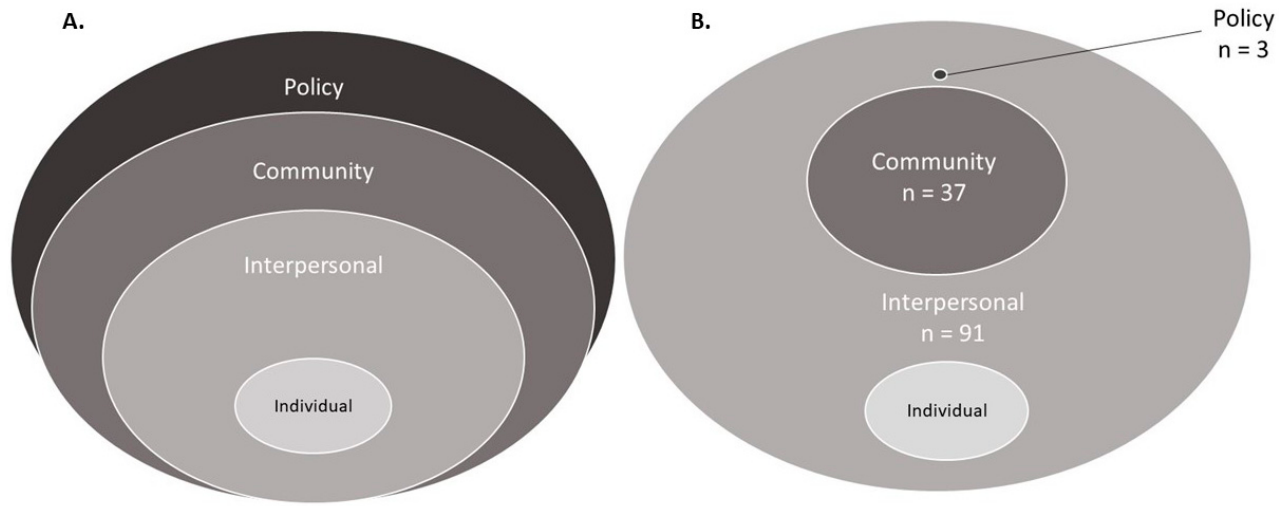
Figure 1. ( A ) Conceptual 3-tier social ecological model for individual cognitive aging and dementia outcomes used to organize studies of social environments included in this review. ( B ) The 3-tier social ecological model rescaled to reflect the proportion of single studies that met inclusion criteria in each ecological level.